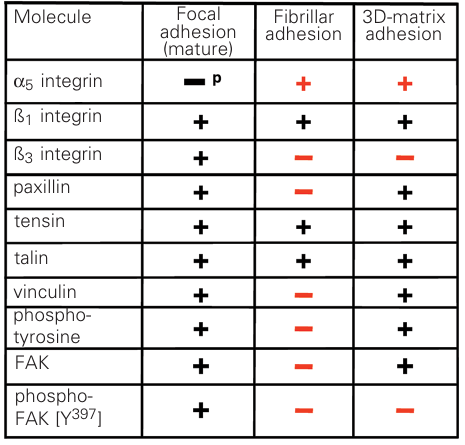
There are similarities and differences between the molecules found in focal, fibrillar, and 3D-matrix adhe- sions as indicated in this table showing selected com- ponents of these cell-matrix adhesions. Components